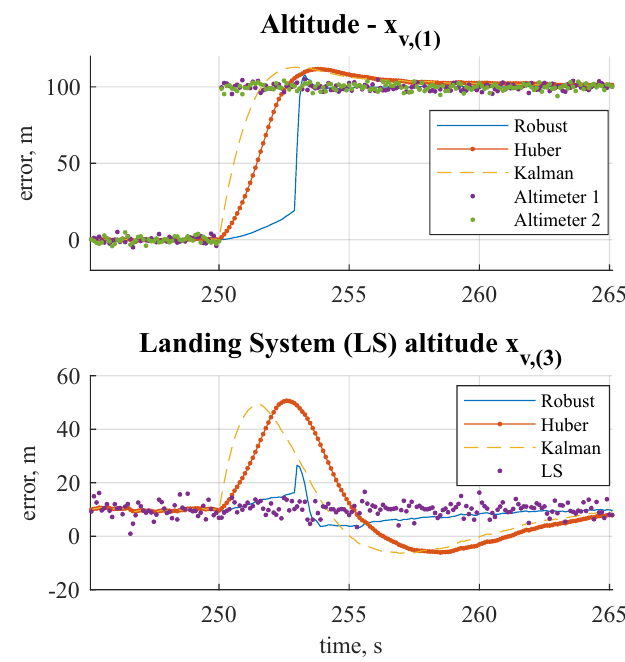
Figure 5. Filter response to step measurements. «Robust»—the proposed robust algorithm. «Huber»—M score.